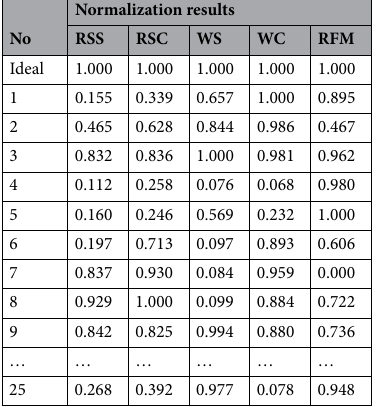
Table 8. The grey relational generation of each objective.